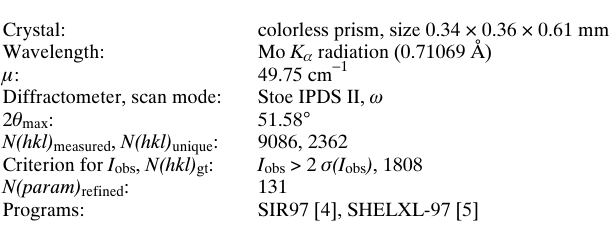
Table 1. Datacollection and handling.